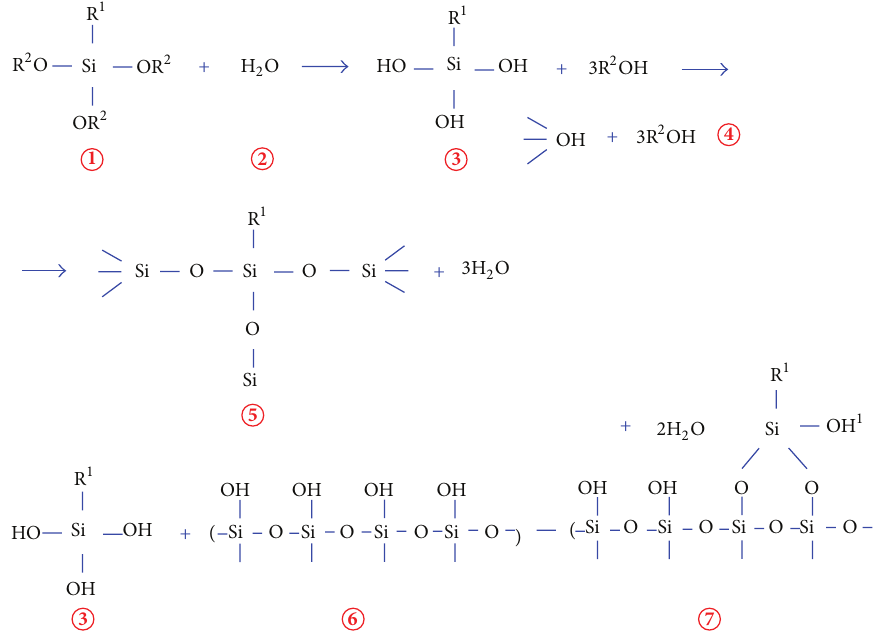
Figure 1: Chemical chain in inorganic